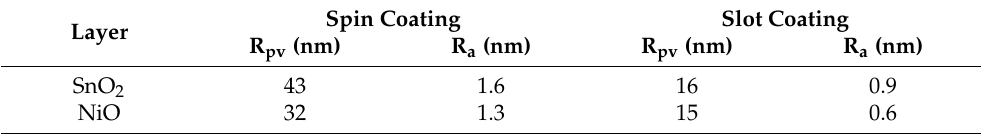
Figure 18. AFM images of ( a ) spin-coated SnO 2 , ( b ) spin-coated NiO, ( c ) slot-coated SnO 2 , ( d ) slot-coated NiO films, and ( e ) image of defects in the spin-coated SnO 2 /NiO films. Table 4. Surface roughness of spin/slot-coated SnO 2 on TiO 2 and NiO on SnO 2